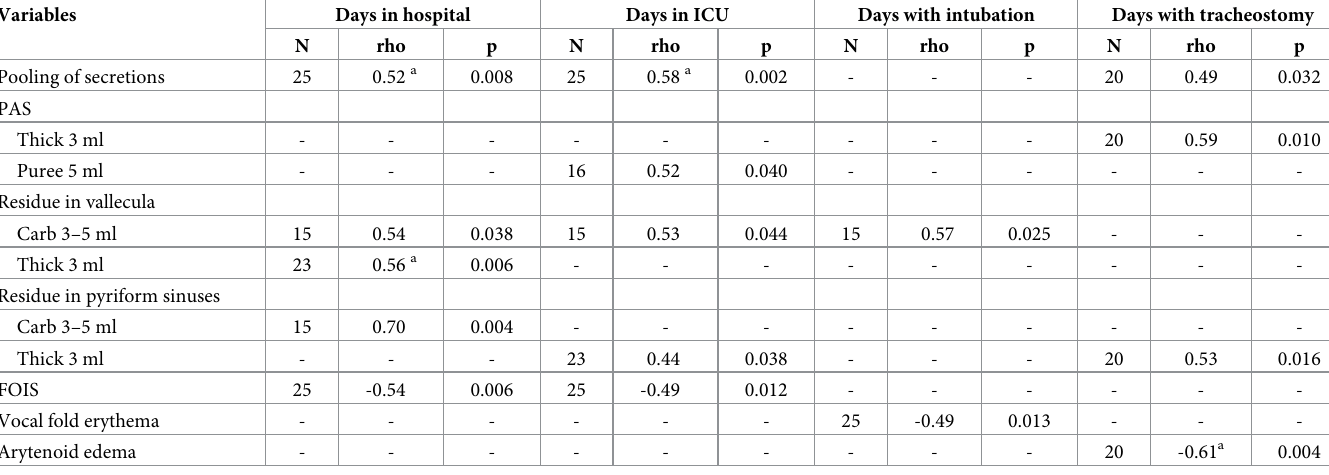
Spearman’s Rank correlations. Variables with data from 15 patients or more are included in the analysis. Correlations with a significance level of p < 0.05 are shown. Ratings from the first FEES examination were used for the analysis. a Post-hoc Kruskal-Wallis test p < 0.05.